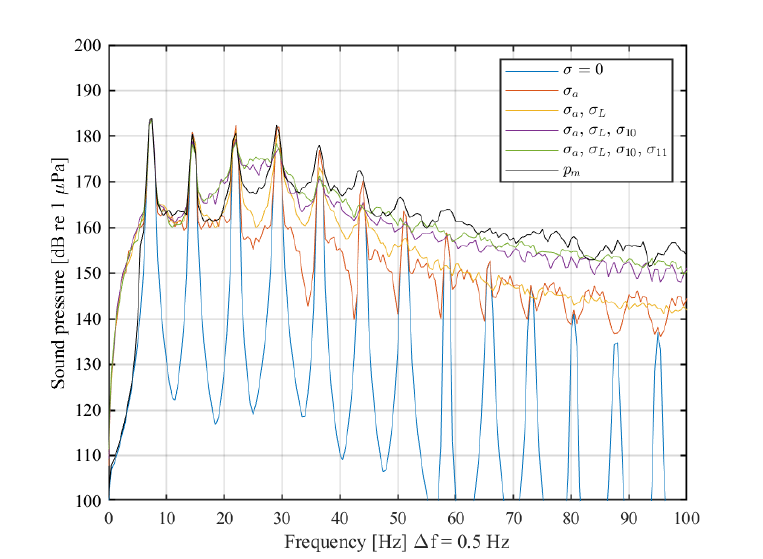
Figure 15. Sound pressure spectra of artificial signals generated by variation of all four shape parameters taking effect successively based on standard deviations evaluated from the measured blade passages as stated in Table 3 for 87.5 rpm in comparison to the unvaried signal (blue) and the measured signal p m